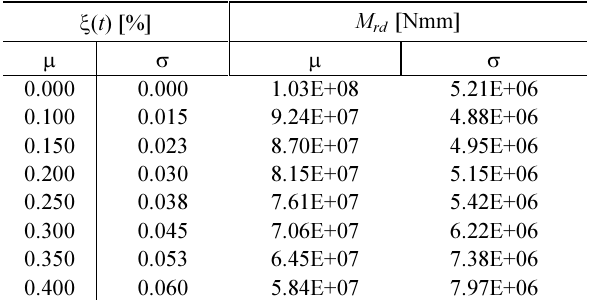
Tables 4. The statistical parameters of the ultimate flexural strength of the cold-formed beam